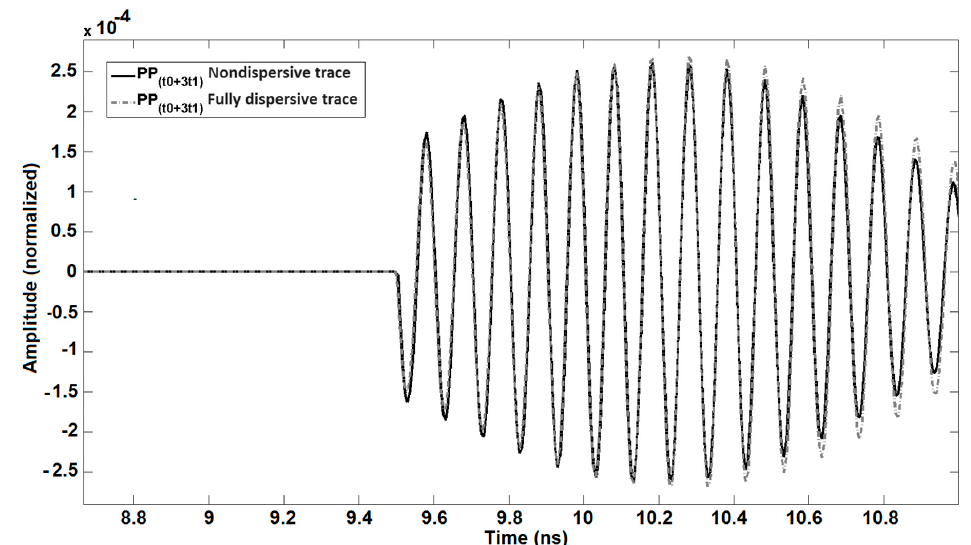
Figure 4. Simulation of nondispersive trace in 10 GHz and fully dispersive trace for 𝑃𝑃 ((cid:3047) The amplitude is normalized.